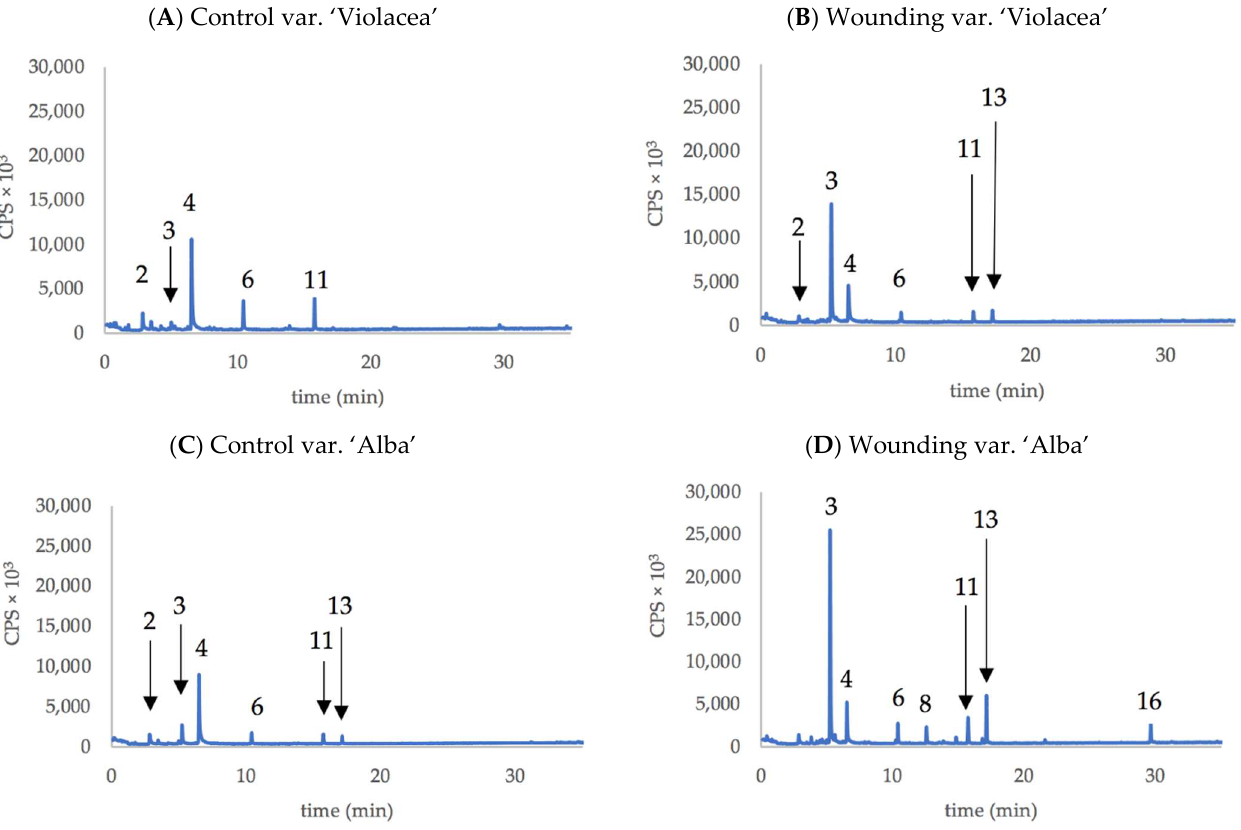
Figure 4. Chromatograms of main VOCs produced by the whole plant of purple-flowered T. violacea (( A ): Control; ( B ): after wounding) and white-flowered T. violacea (( C ): Control; ( D ): after wounding). Numbers indicate the compounds listed in Table 2. Table 4. Semi-quantitative determination of (Z)-3-Hexenyl acetate emitted after wounding by whole plants of white-flowered and purple flowered T. violacea (ng/plant in 5 h).